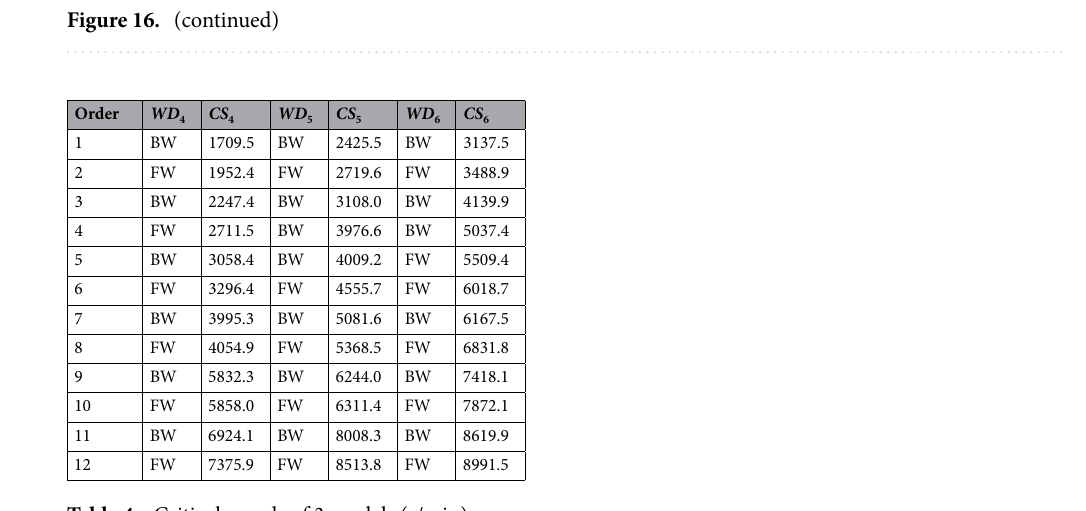
Table 4. Critical speeds of 3 models